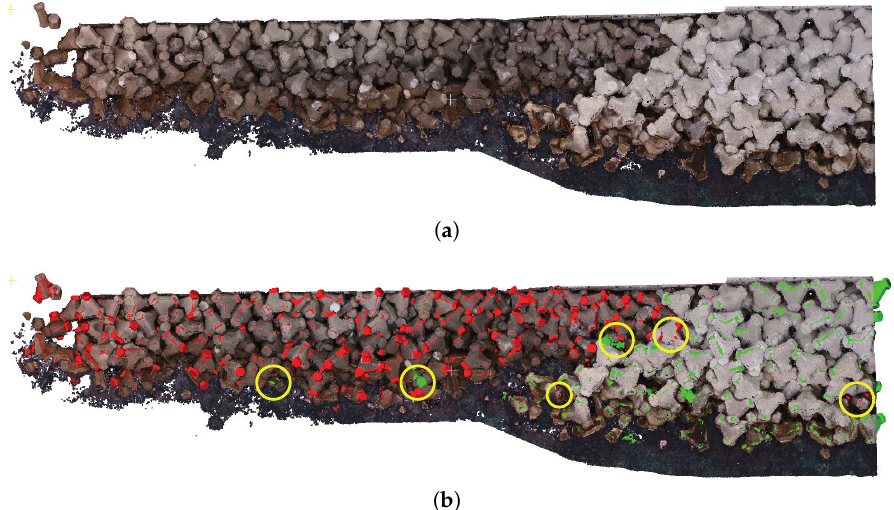
Figure 19. Visualization of results of block-type classification on Era port. ( a ) is the real point cloud scene of the Era port measured by UAV, and ( b ) is the result of type classification after instances segmentation and pose estimation. Block A2 and Block A3 are rendered in red and green, respectively. Yellow circles indicate misclassified